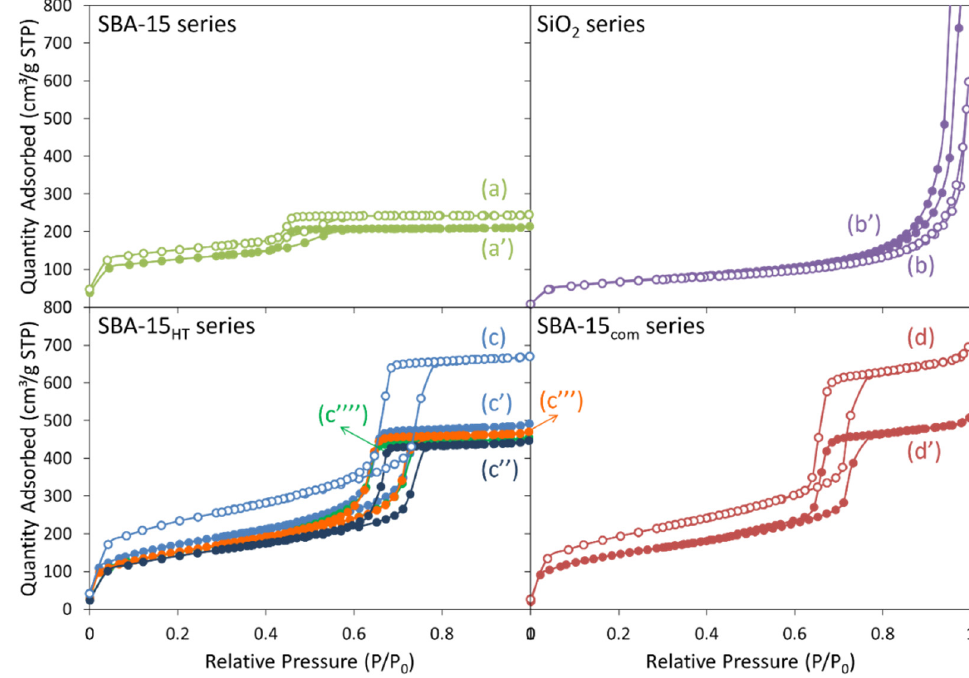
Figure 1. N 2 sorption isotherms of the calcined ( a ) SBA-15, ( a’ ) Ni/SBA-15(N), ( b ) SiO 2 , ( b’ ) Ni/SiO 2 (N), ( c ) SBA-15 HT , ( c’ ) Ni/SBA-15 HT (N), ( c’’ ) Ni/SBA-15 HT (R), ( c’’’ ) Ni/SBA-15 HT (A), ( c’’’’ ) Ni/SBA-15 HT (Cl), ( d ) SBA-15 com , and ( d’ ) Ni/SBA-15 com (N). The X-ray diffractograms of the calcined samples (Figure 2) reveal a broad signal at around 22° corresponding to X-rays diffusion by amorphous silica walls and narrower diffractions peaks at 37, 43, 62, 76, and 81° characteristic of nickel oxide (JCPDS 73-1523) with a face-centered cubic lattice (Fm-3m), as obtained in a previous study [12], and their average particle sizes (Table 1) were estimated from the full width at half maximum (FWHM) using the Scherrer equation, detailed in Section 4.2. These peaks are almost ab- sent on Ni/SBA-15 HT (A) (Figure 2a), indicative of the formation of very small NiO nano- particles. Similarly, small NiO nanoparticles were found on Ni/SBA-15 com (N) (Figure 2b), whereas the largest NiO nanoparticles were formed on Ni/SBA-15 HT (Cl) (Figure 2d) and